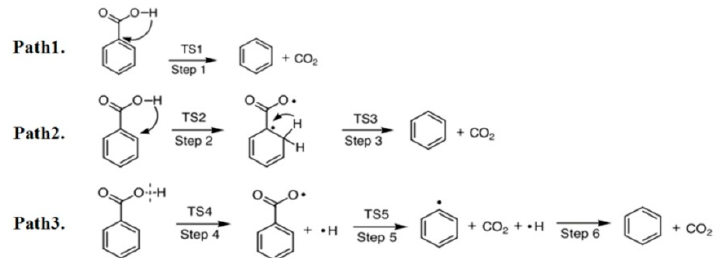
Figure 1. Three pathways for the pyrolysis of C 6 H 5 COOH.